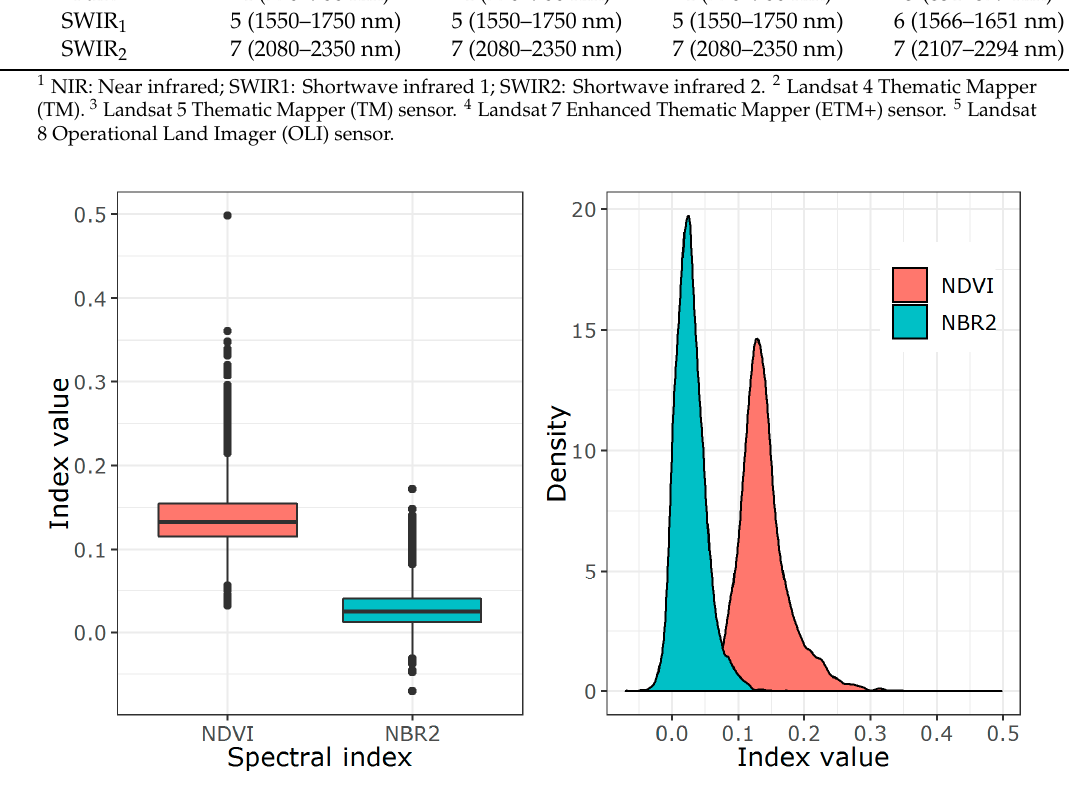
Figure A1. Boxplot and density plot of spectral indices calculated from the convolved reflectance measurements of LUCAS topsoil samples. Normalized Difference Vegetation Index (NDVI) and Normalized Burn Ration 2 index (NBR2) are used to identify potential soil pixels on satellite images.